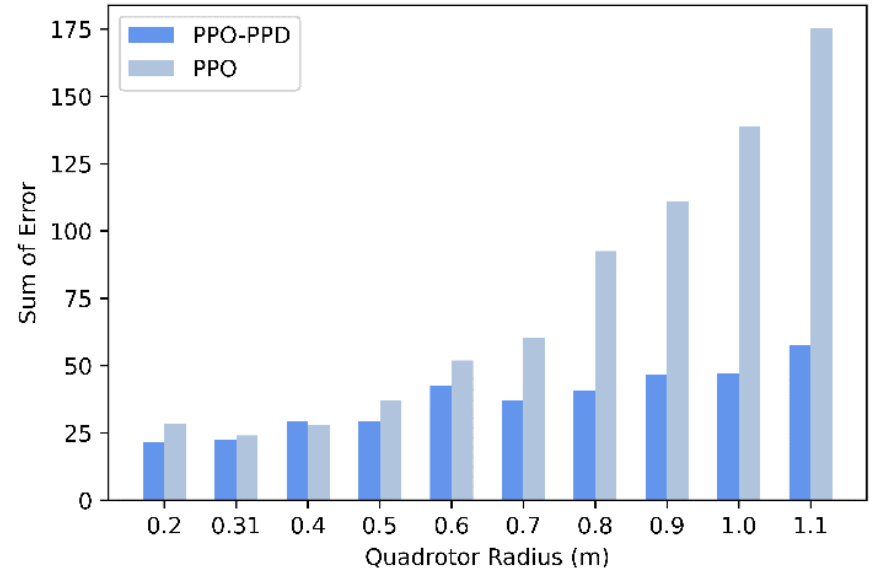
Figure 14. Sum of error in different sizes between the PPO-PPD algorithm and PPO algorithm.